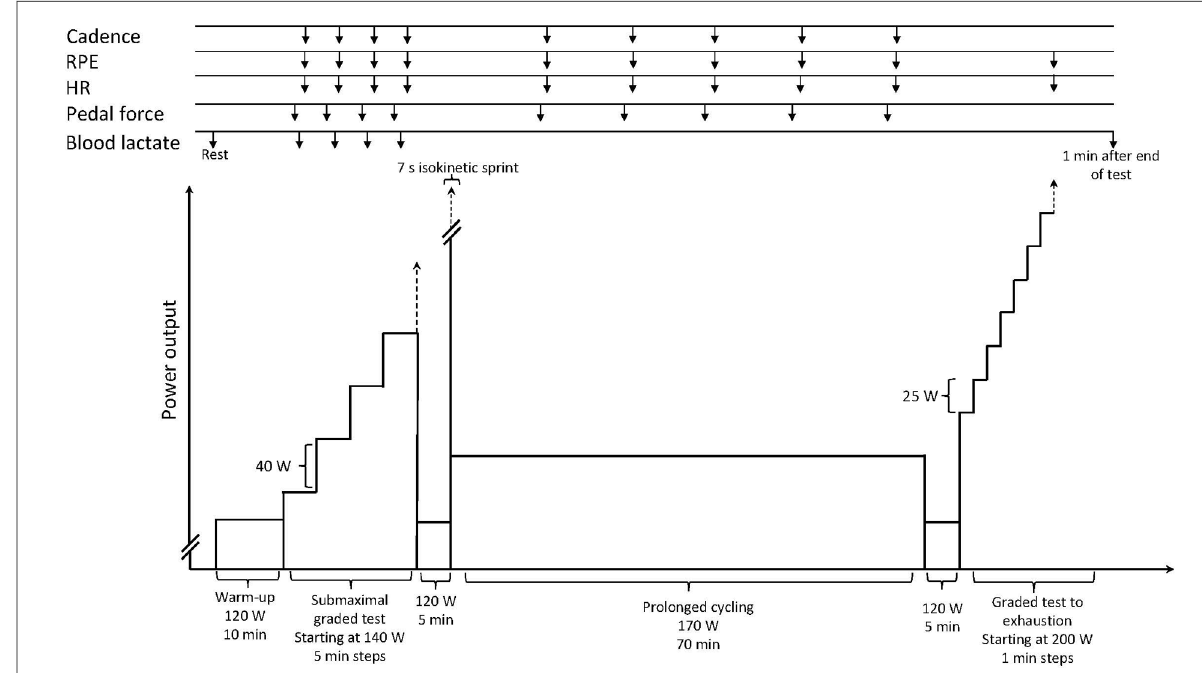
FIGURE 1 Illustration of test session two, which was applied at both pre- and posttest. The session contained several uninterrupted bouts of cycling and tests for measurement of performance indicators. Included is an overview of time points for sampling of diverse